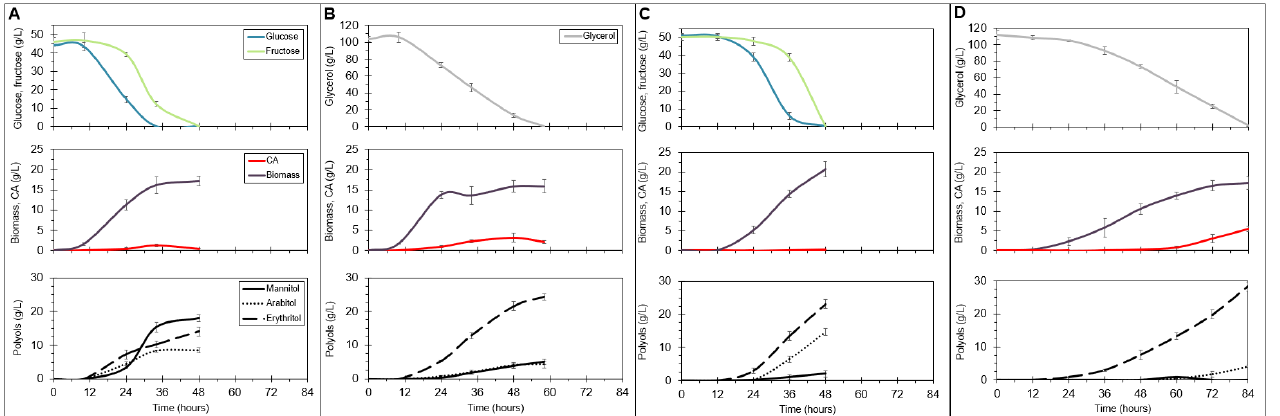
Figure 4. Substrate utilization, growth, citric acid (CA) and polyol production by the strain Y. lipolytica SpH1-Y1-Y3-Y4 in 5 L stirred-tank bioreactors in media optimized for polyol production containing a mixture of glucose and fructose ( A ) or glycerol ( B ); in media optimized for erythritol production containing a mixture of glucose and fructose ( C ) or glycerol ( D ). The cultivations were performed in three biological replicates.